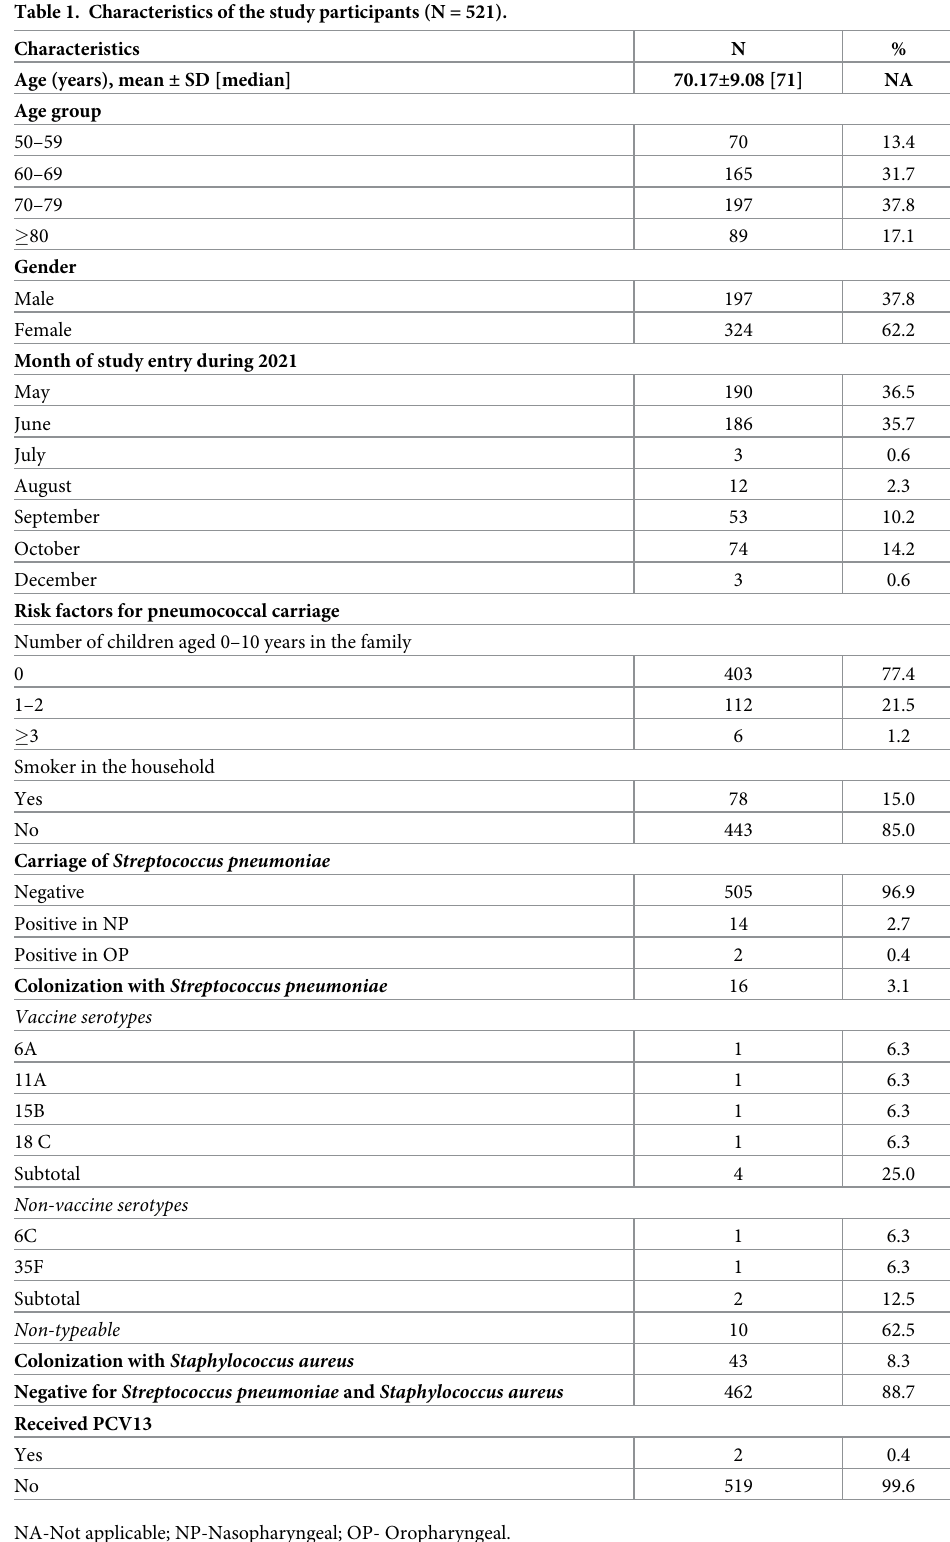
Table 1. Characteristics of the study participants (N =